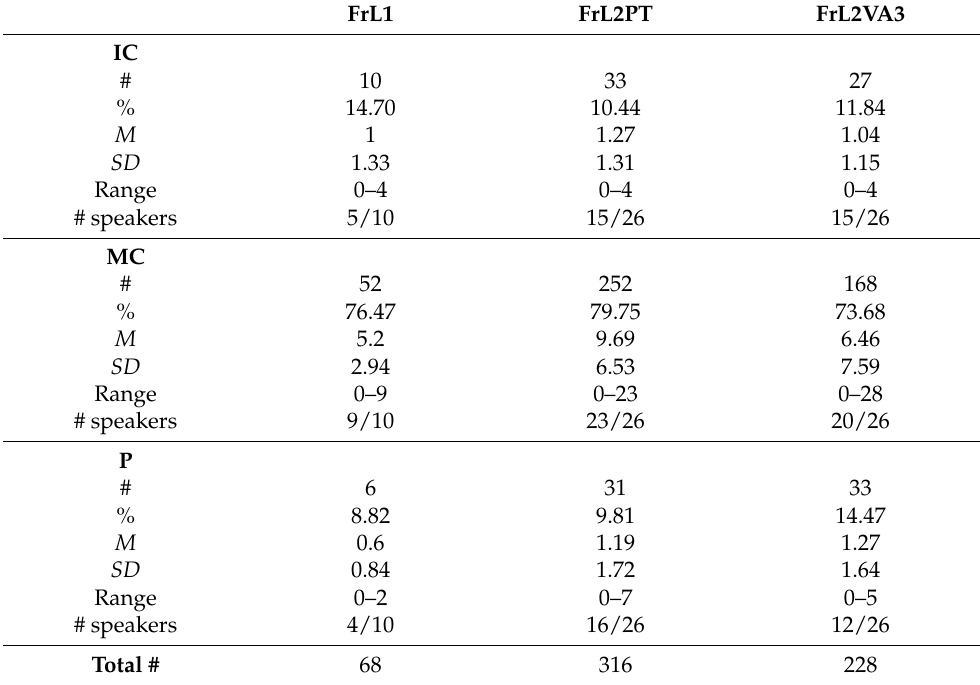
Table 2. Syntactic distribution of je pense in the database—descriptive